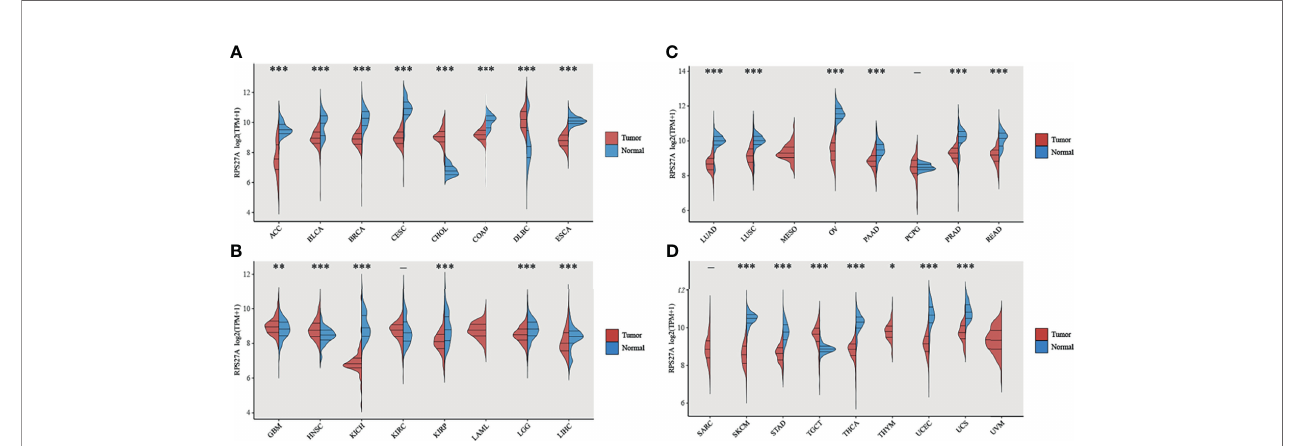
FIGURE 7 | Expression levels of RPS27A in different tumor tissues. (A – D) Differences in RPS27A expressions in 33 different tumor tissues and normal tissues in The Cancer Genome Atlas (TCGA). *p < 0.05, **p < 0.01, ***p <